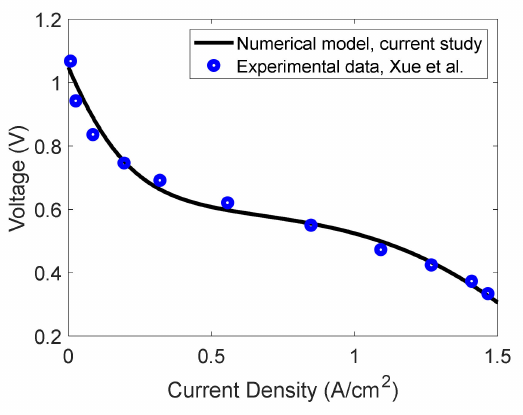
Figure 10. Validation results of the developed model at high current densities with the Ballard Mark V PEM fuel cell given by Xue et al. [44].